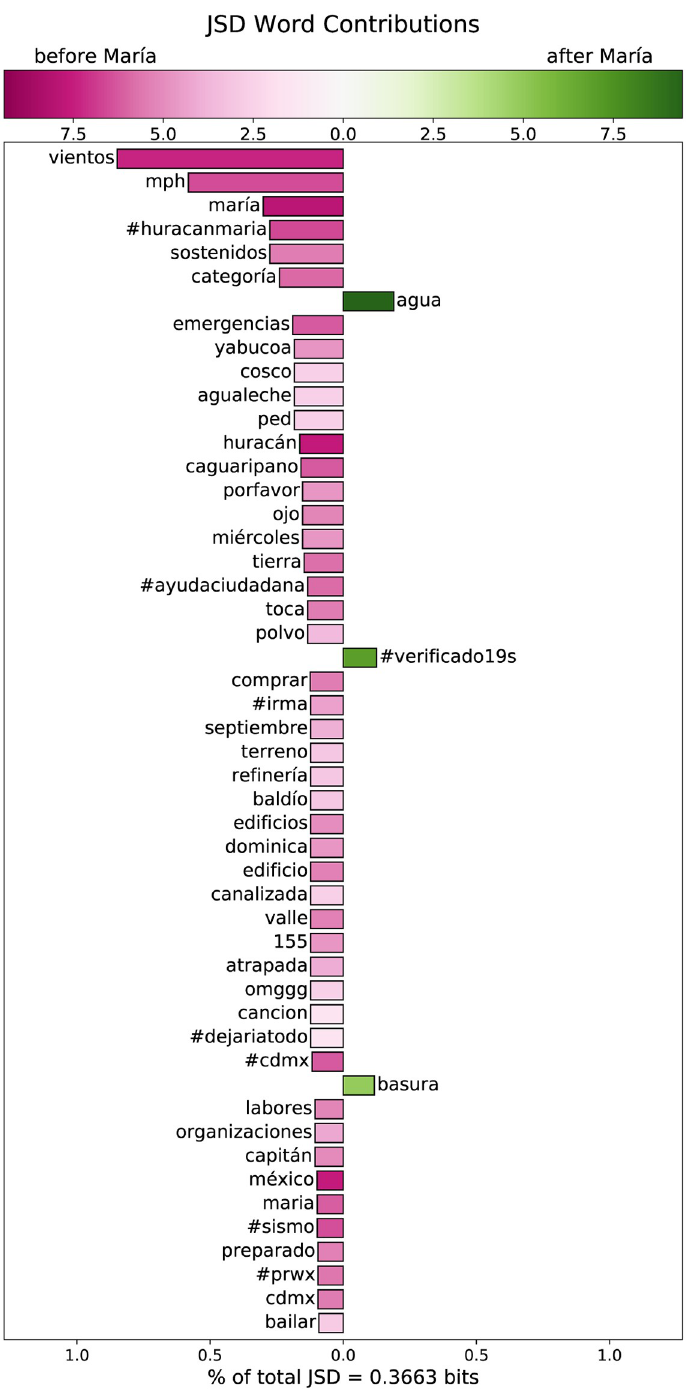
Fig 9. The contributions of individual words to the Jensen-Shannon divergence between the collection of tweets before and after the period of landfall for Hurrican Maria. The length of each bar indicates the contribution of a word, and its direction indicates the corpus in which it was more frequent. The bars are colored according to the Shannon entropy of the Tweets that contained that word, hashtag, or emoji.